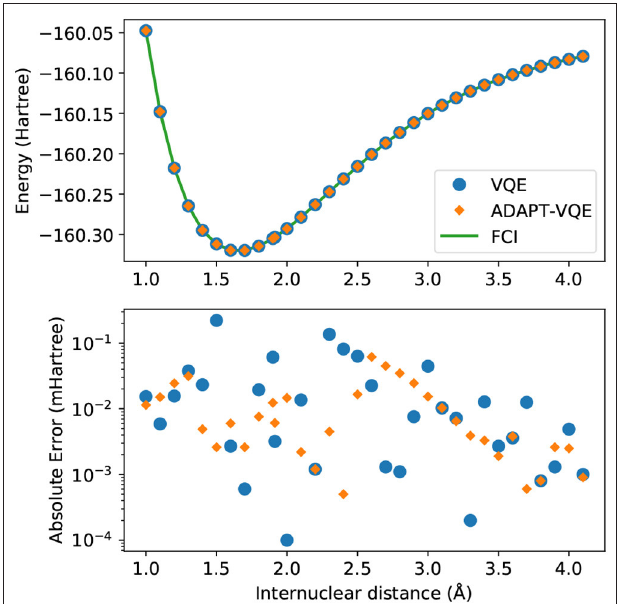
FIGURE 3 | (Top) Potential energy curves of KH computed with the STO-3G basis set for FCI (green solid line), VQE (blue circles), and ADAPT-VQE (orange diamonds) with the COBYLA optimizer. (Bottom) Absolute error in the minimized energy for VQE (blue) and ADAPT-VQE (orange) relative to the FCI reference value.